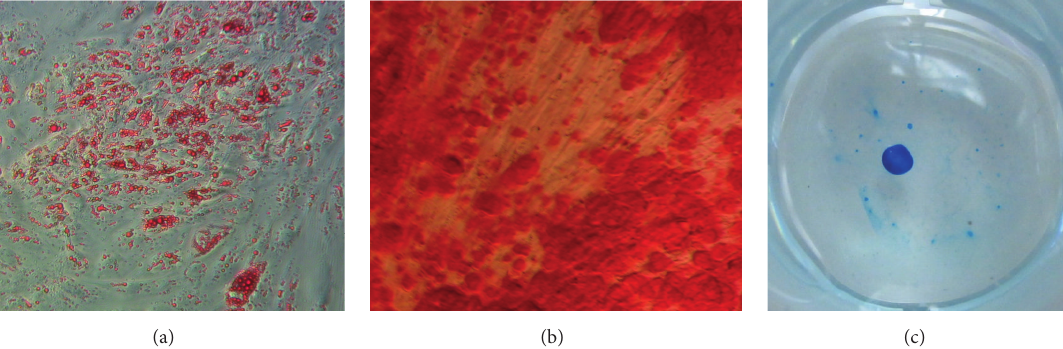
Figure 4: Differentiation of tPR cultured ASCs along adipogenic, osteogenic, and chondrogenic lineages. Passage 2 ASCs grown in 10% tPR still retained the ability to differentiate into adipocytes ((a) Oil Red O), osteocytes ((b) Alizarin red), and chondrocytes in a micromass culture ((c) Alcian